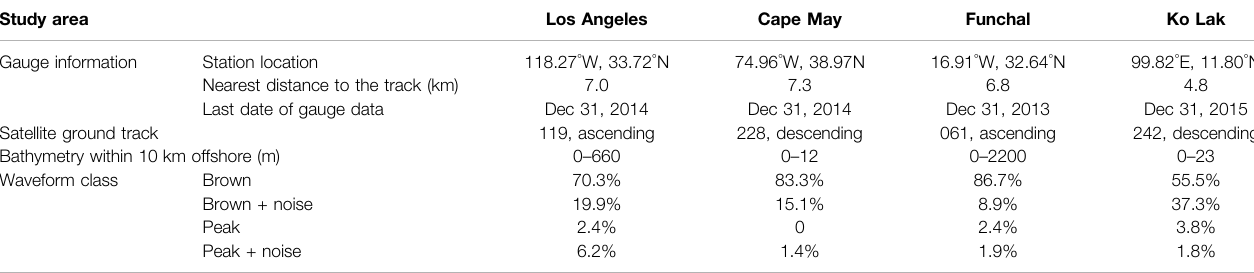
TABLE 1 | General information of study